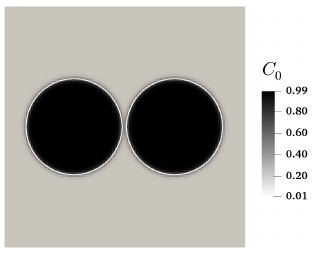
Figure 1. Problem 3.1: distribution of C 0 . The white color indicates the isoline with C = 0 . 5. as well as ε c = 0 . 01 defining the “offset” of values C 0 from 0 and 1, see Figure